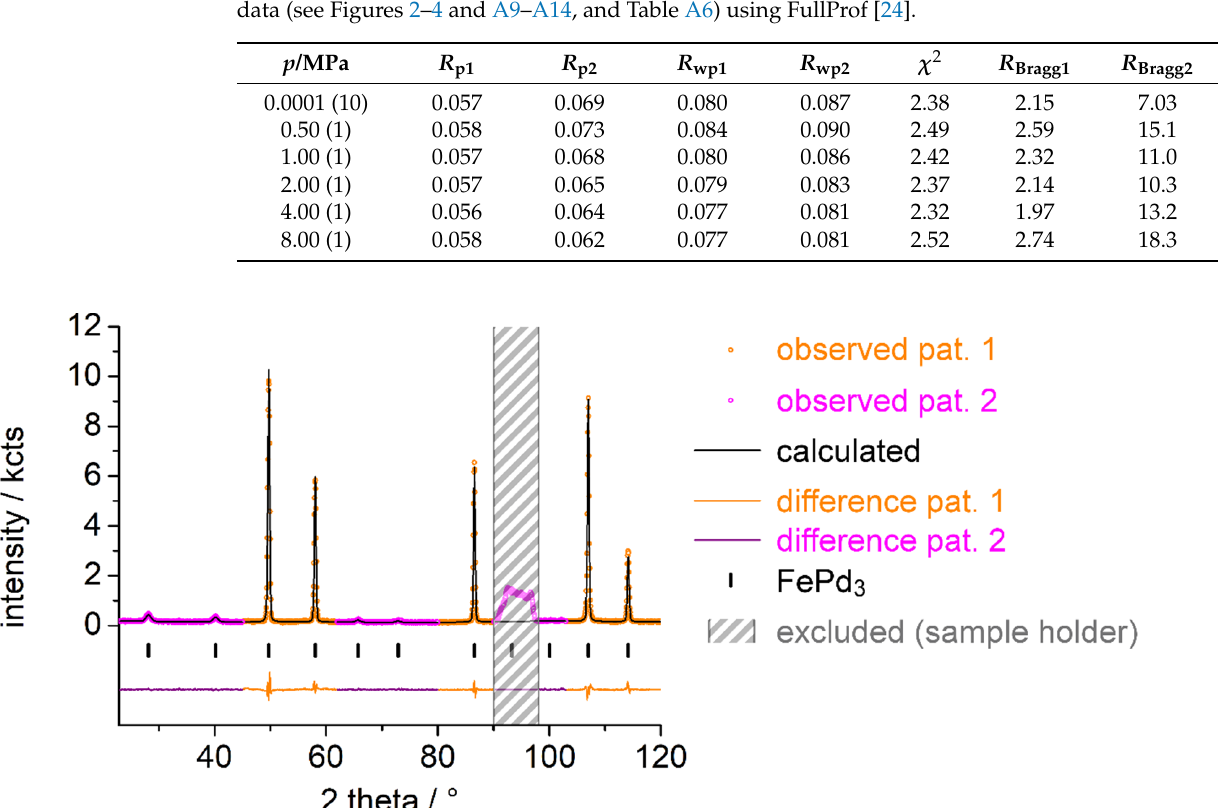
Table A7. Residual parameters of the Rietveld refinement of FePd 3 ( Pm 3 m ) based on in situ NPD data (see Figures 2–4 and A9–A14, and Table A6) using FullProf [24].